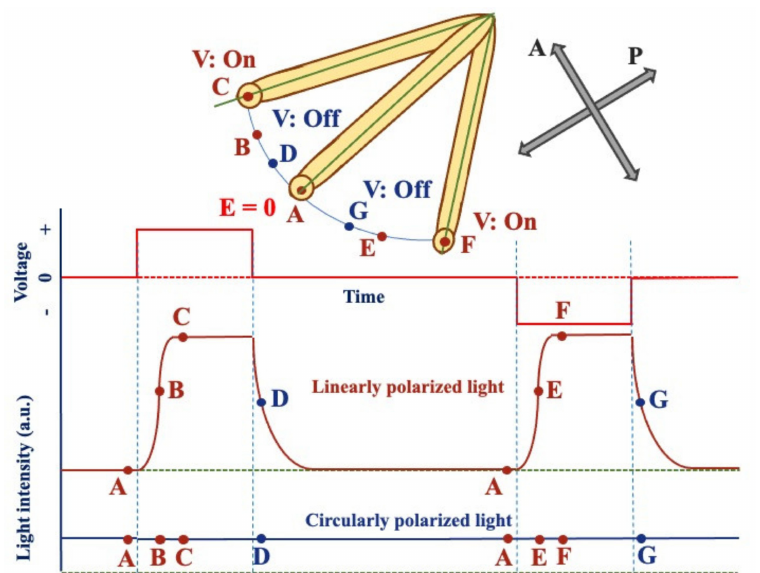
Figure 14. Liquid crystal molecular director switching model for the uniformly stacked SSD-LC panel. In the uniformly stacked SSD-LC panel, the liquid crystal molecular director switches in the same plane as the initial aligned